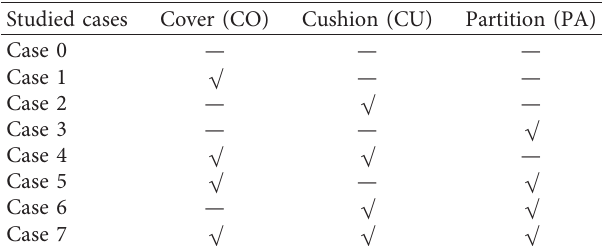
Figure 6: Field meteorological data: (a) rainfall; (b) temperature; (c) relative humidity; (d) wind speed [23]. Table 2: Numerical program of sand cushion without and with atmospheric